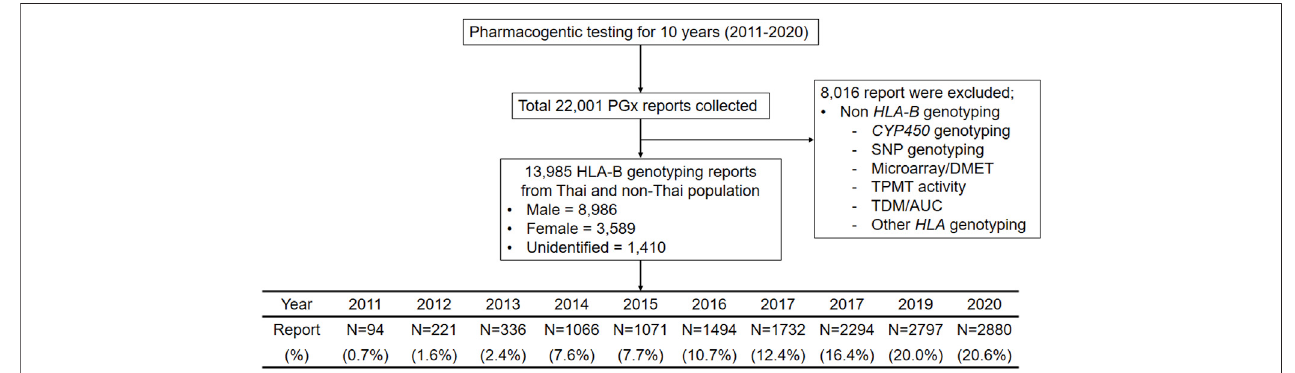
FIGURE1| Flowchart ofClinical pharmacogenomics study designed, inclusion and exclusion criteriafor10 yearsduring 2011 – 2020. This fl ow diagram illustrates the pharmacogenetic reports collected in this study, the number of reports (N = 22,001) and inclusion and exclusion